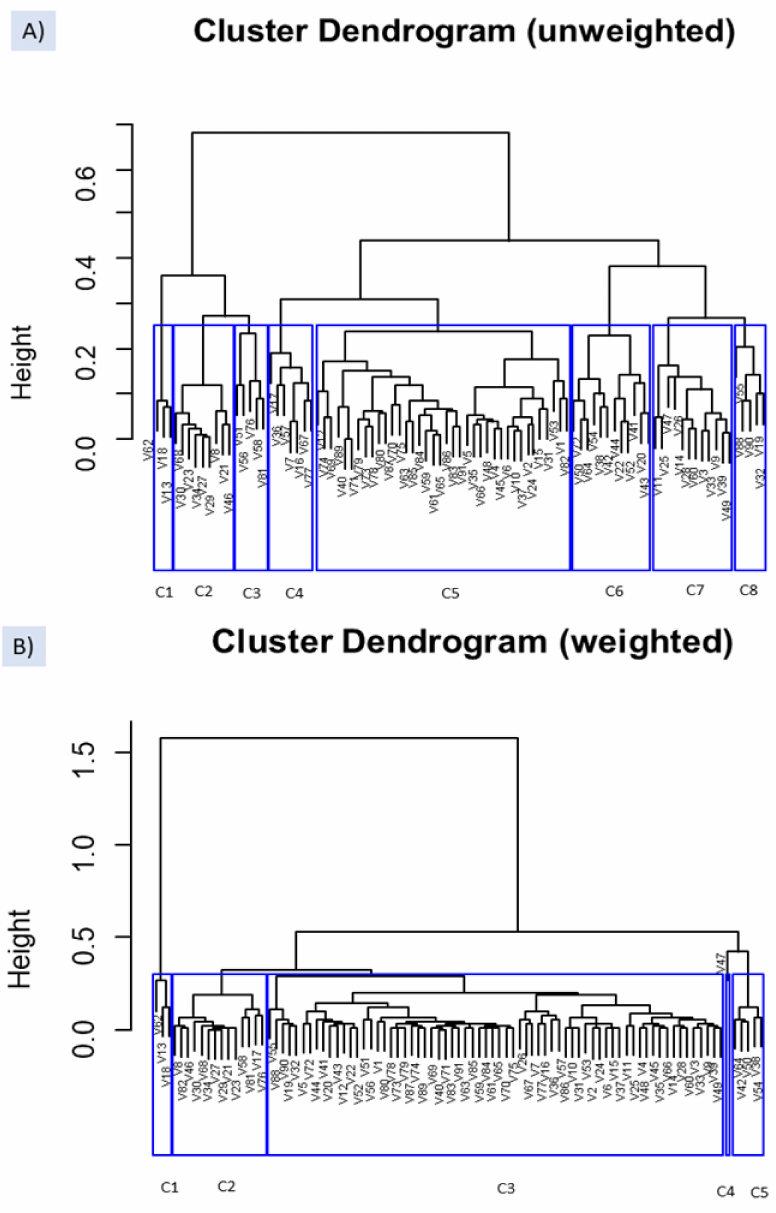
Figure 7. Clustering of VOCs, based on clr coefficients , using the function WARD from easyCODA with the unweighted ( A ) and weighted ( B ) options. See Table S1 for the meaning of VOCs’ symbols. Regarding the unweighted option, C2 cluster included highly significant and almost exclusive compounds associated with the ANOVA to sample F282 (affected by the butyric spoilage) (Table S2). Similarly, most of the VOCs grouped into cluster C7 were charac- terised by the exclusive significant-high contribution of F508 (affected by sulfidic spoilage) to their ANOVA models. Besides, (Z)-3-hexen-1-ol (V47) was present in all the samples and dimethyl sulfoxide in all except in F282 and F283. Among the compounds included in cluster C8, only D-limonene (V32) was exclusively related to F562. The rest of the compo- nents were mainly linked by the ANOVA to sample F562 (putrid) and other samples. VOCs included in cluster C3 were primarily associated with samples from industry A, including F282 and F283. C4 was composed mainly of VOCs from samples F282 and F283 (putrid) or industry B like F508 and F562, affected by sulfidic and putrid. C6 grouped compounds related to most samples, while VOCs included in C5 did not follow identifiable